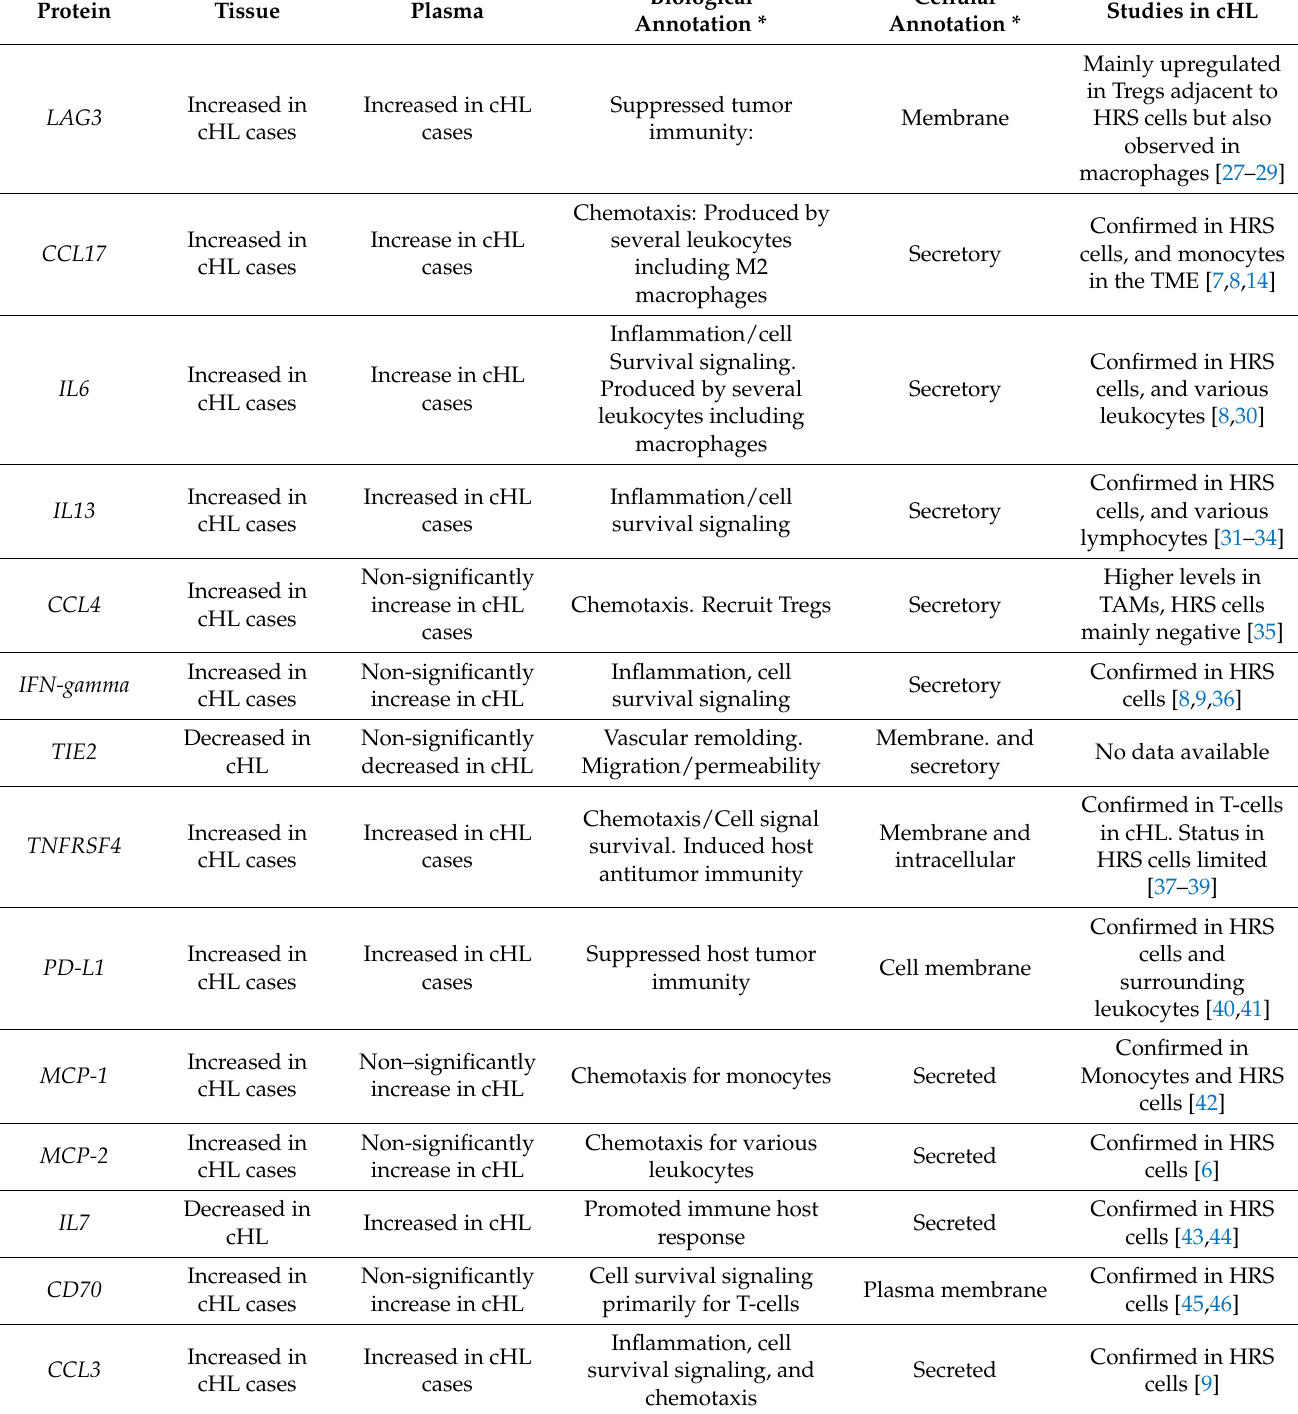
Table 3. Summary of 17 proteins that distinguished cHL tissues from control